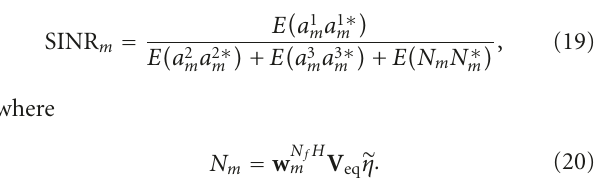
Table 1: | λ max | / | λ min | values for three channel realizations of channel model [12] (CR: channel